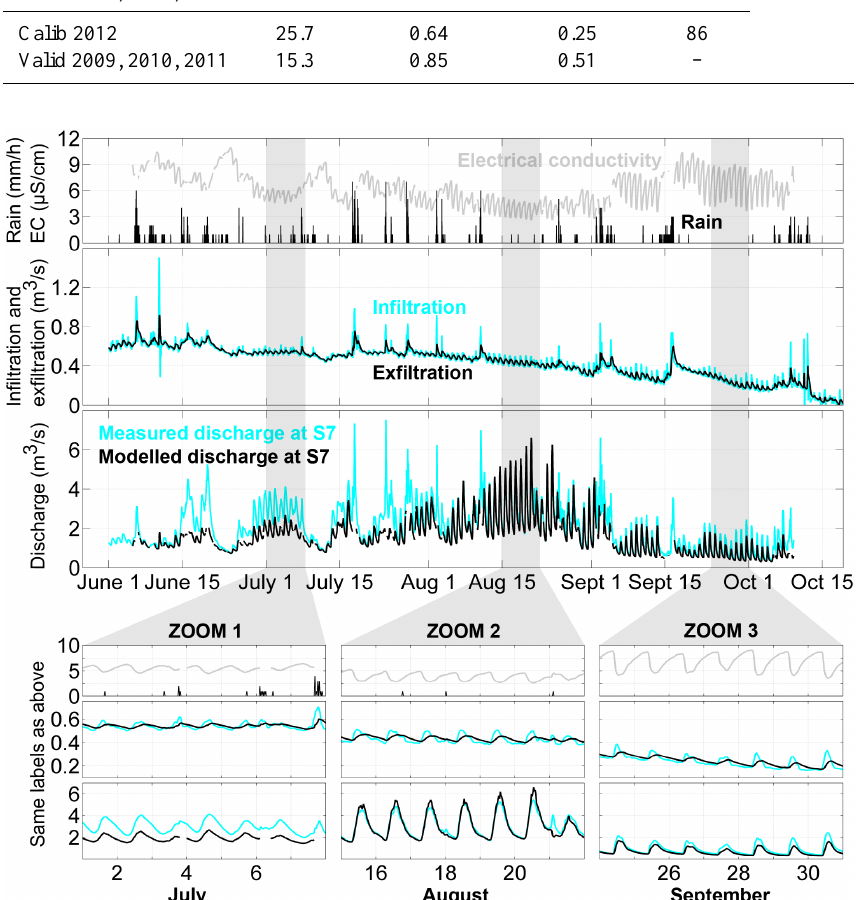
Figure 4. The upper section presents model results for the entire 2009 season. The lower section presents enlargements of 3 specific weeks. For each group of three graphs, the bottom panel displays both measured and modelled discharge (m 3 s − 1 ) at S7. The middle panel presents infiltration and exfiltration (m 3 s − 1 ). Electrical conductivity (µScm − 1 ) and rainfall (mmh − 1 ) are plotted in the upper panel. Time periods that were filtered out can be seen as gaps in the EC data (e.g. in zoom